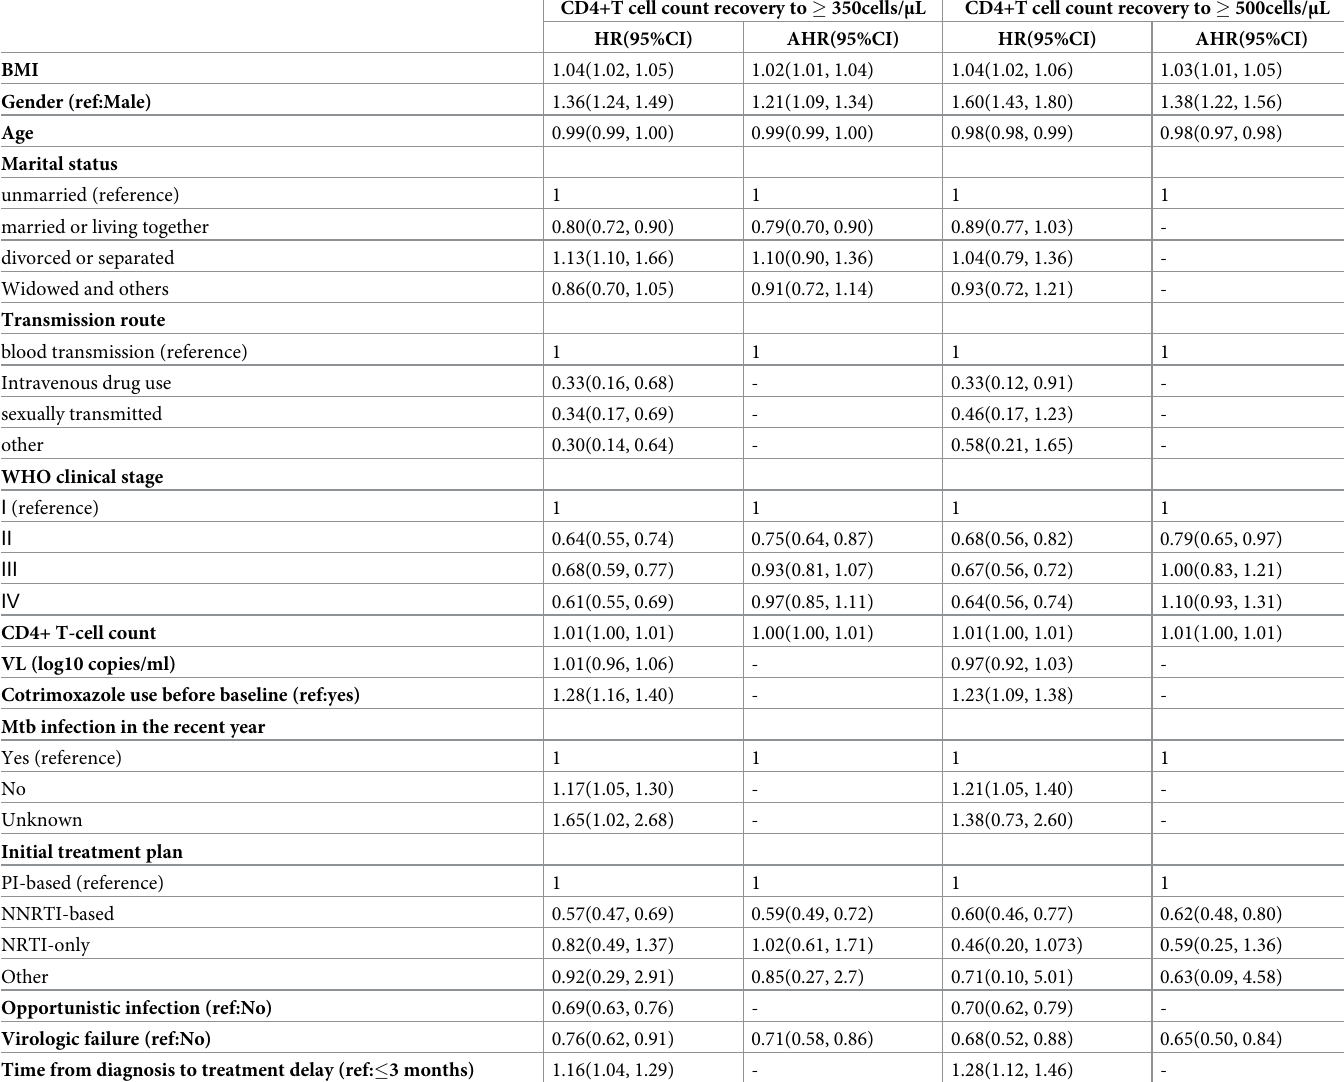
Table 3. The associated factors of CD4+ T cell count recovery to the endpoints ( � 350, 500 cells/ μ